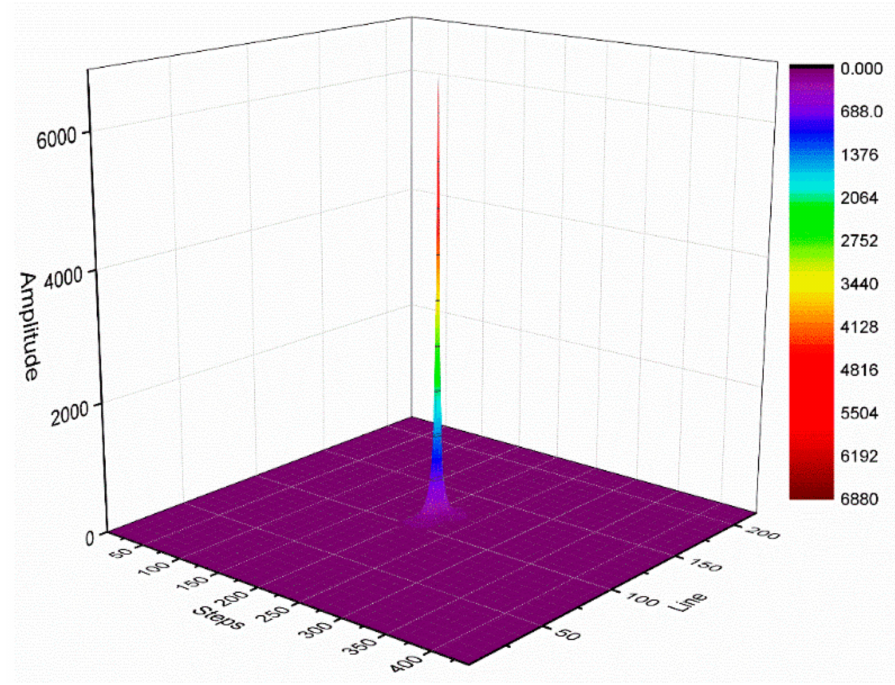
Figure 4. k-space signal amplitude distribution